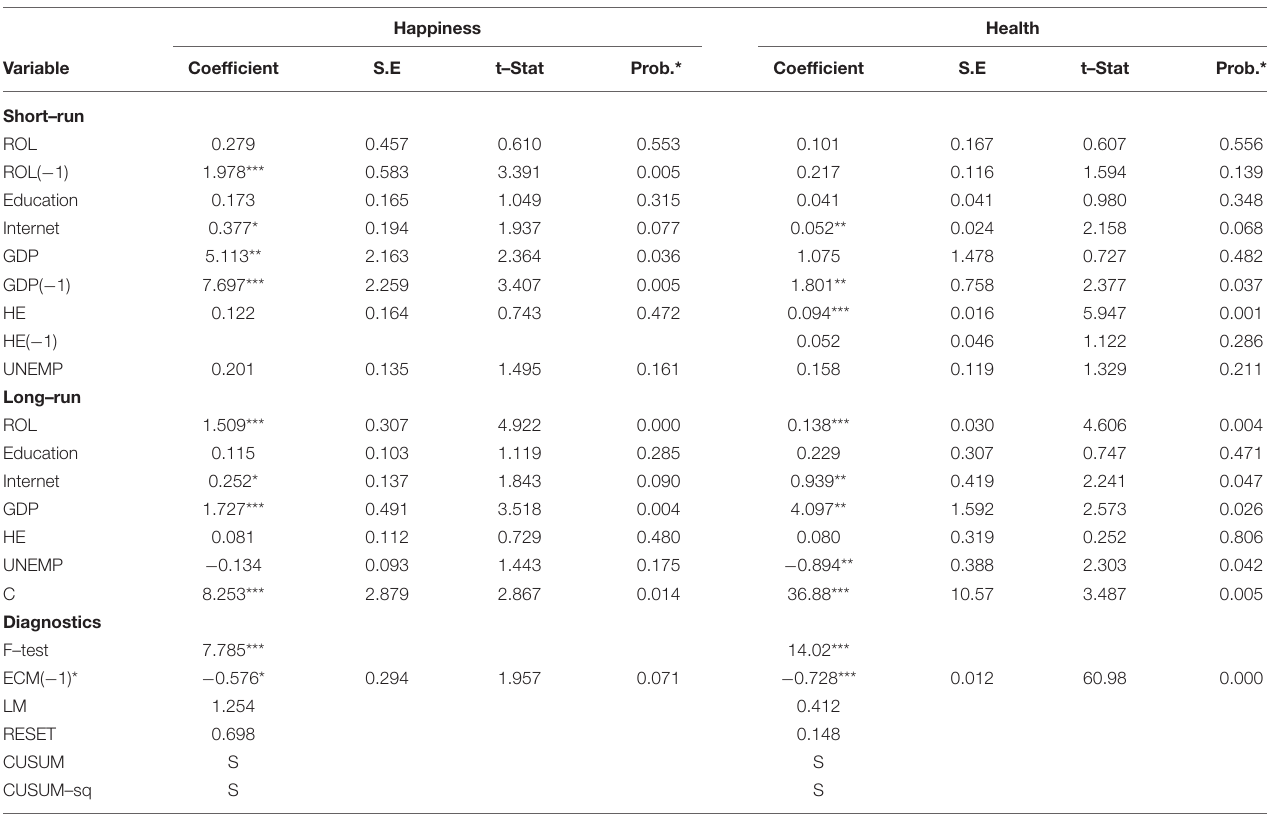
TABLE 3 | Long and short-run estimates of happiness and